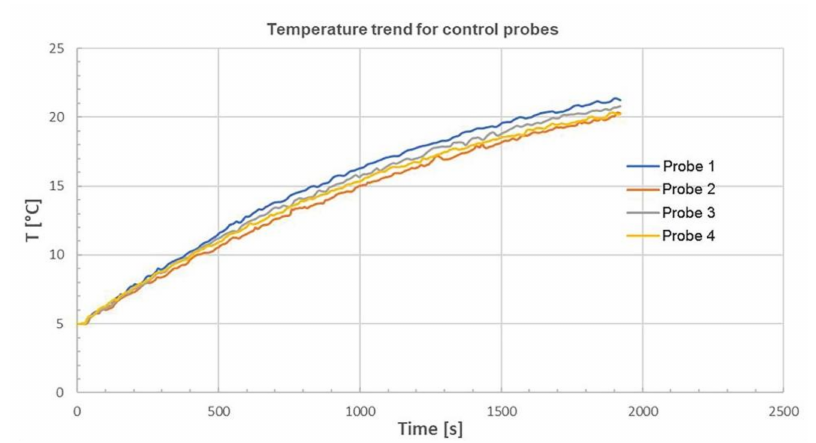
Figure 16. Temperature